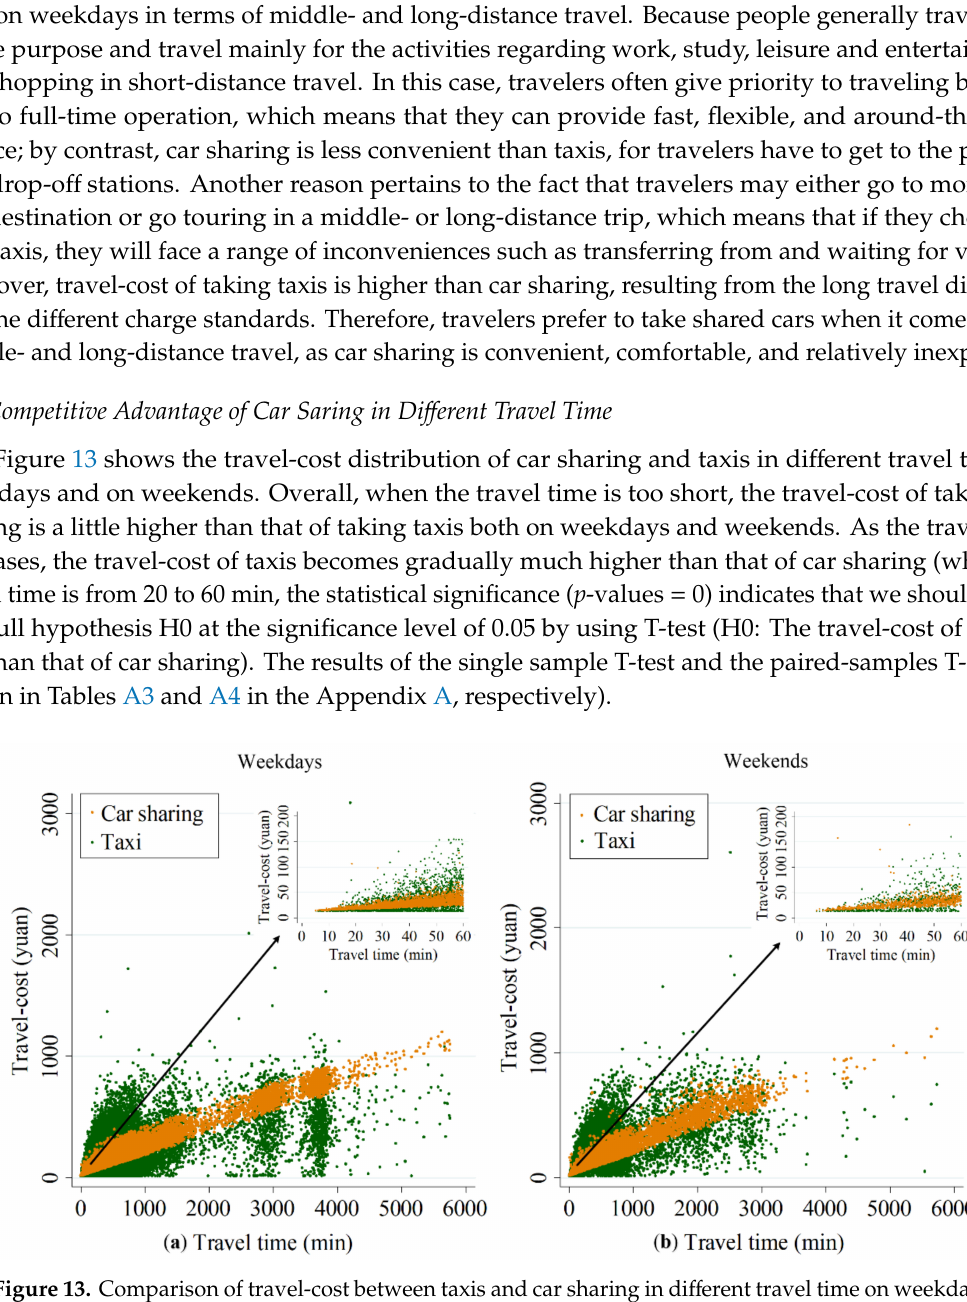
Figure 13. Comparison of travel-cost between taxis and car sharing in di ff erent travel time on weekdays ( a ) and on weekends ( b